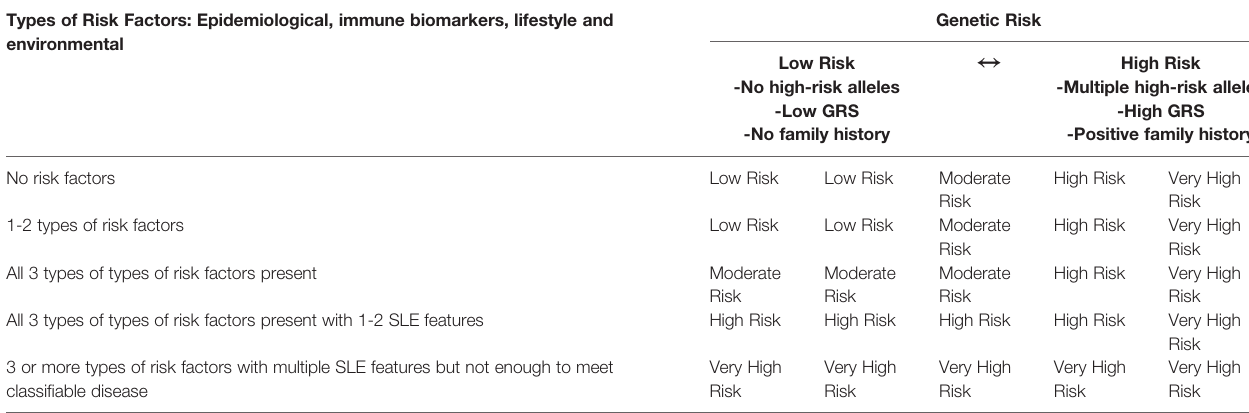
TABLE 2 | SLE risk strati fi cation chart. Types of Risk Factors: Epidemiological, immune biomarkers, lifestyle and